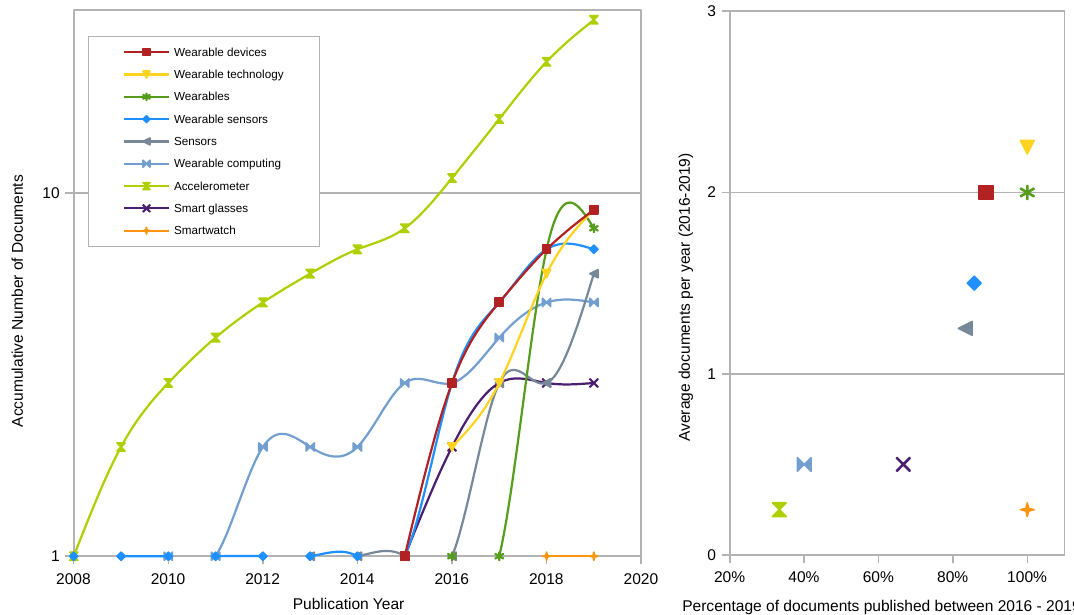
Figure 7. Evolution and relevance of the application of technology and wearable